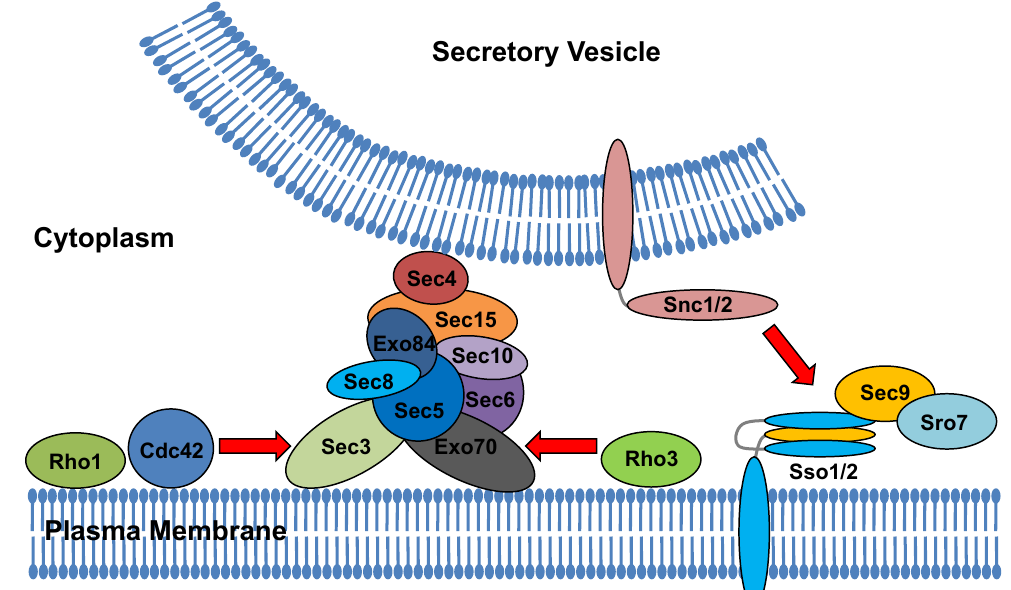
Figure 2. A model of the exocyst and SNARE complex. The exocyst is an octameric protein complex that marks the sites of exocytosis by facilitating the tethering and fission of late secretory vesicles to the plasma membrane. Based on data from S. cerevisiae , Sec3 and Exo70 proteins directly associate with phosphatidylinositol 4,5-bisphosphates in the plasma membrane. Assembly of the remaining exocyst components occurs as secretory vesicles arrive. The exocyst then functions to tether secretory vesicles to the exocytic sites and regulate SNARE assembly. The exocyst component Exo84 also interacts directly with Sro7 protein, which is a downstream e ff ector of the small Rab-like GTPase Sec4, which regulates post-Golgi secretion. Additional regulation of the exocyst complex is performed by the Rho GTPases: Rho1, Rho3 and Cdc42. Snc1 / 2 proteins are the v-SNARES and Sso1 / 2 and Sec9 proteins are the t-SNARES required for final vesicle fusion to the plasma membrane just preceding exocytosis. The functionally redundant Snc and Sso S. cerevisiae proteins arose through genome